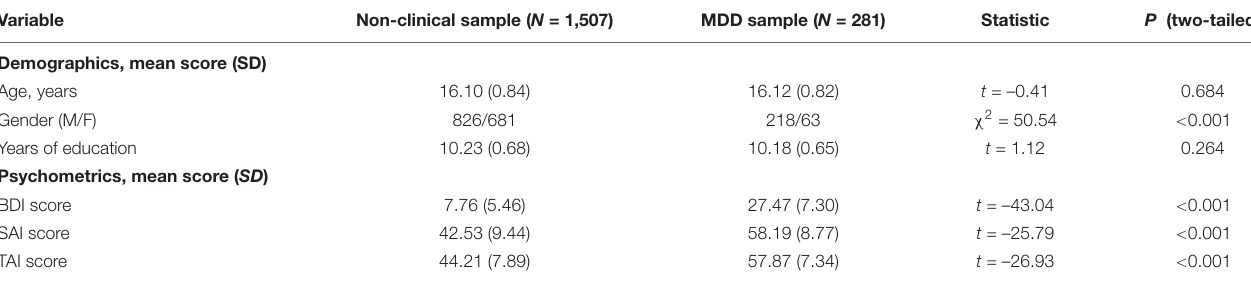
TABLE 1 | Demographic information of the Non-clinical and MDD samples.